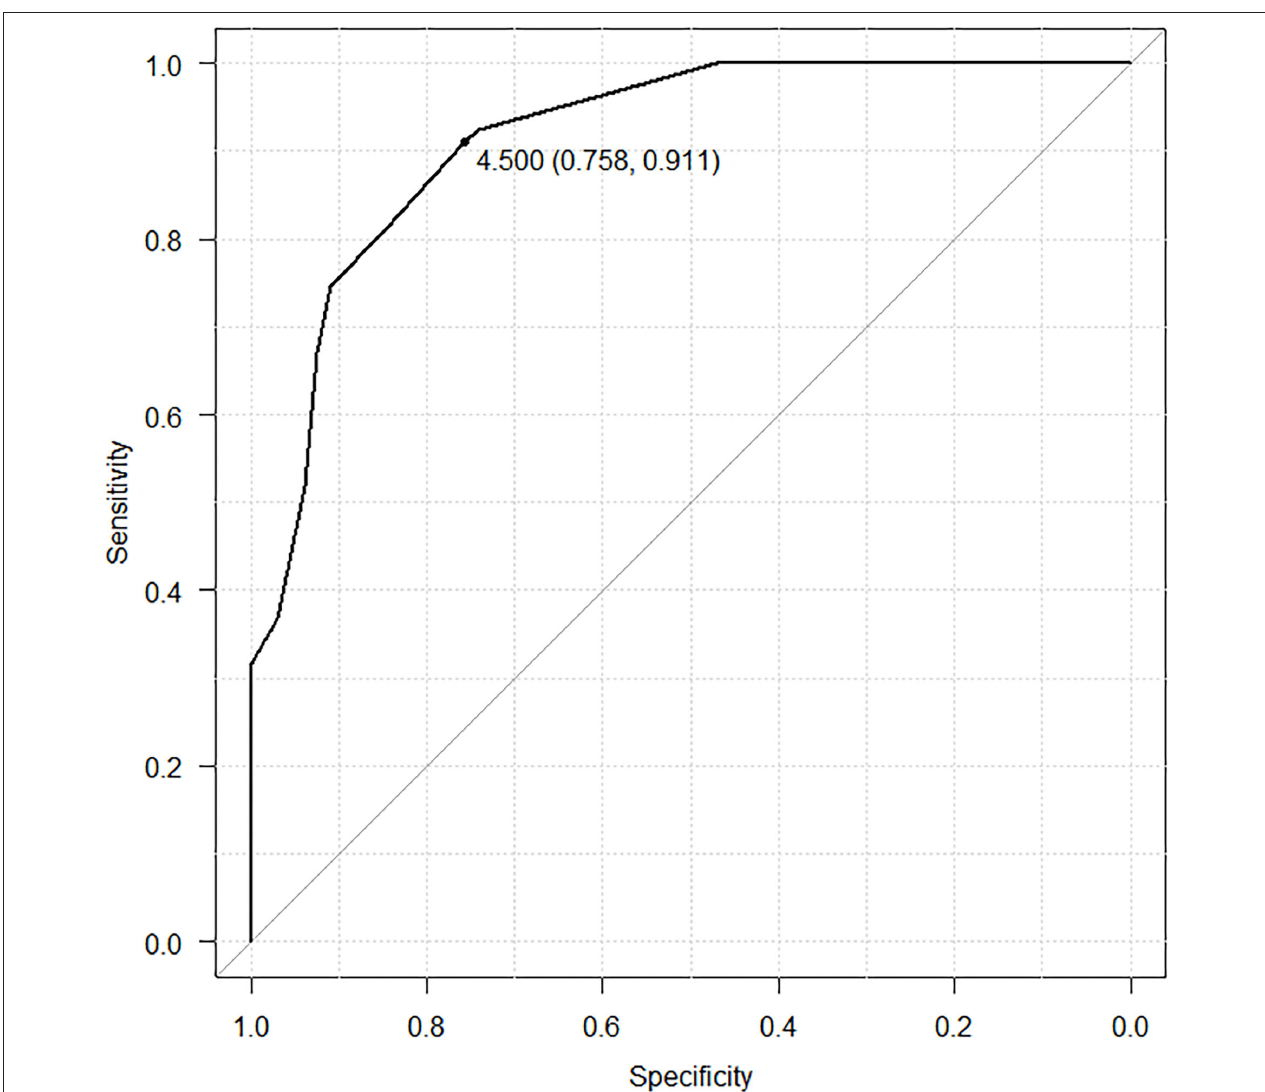
FIGURE 1 | ROC curve of scoring